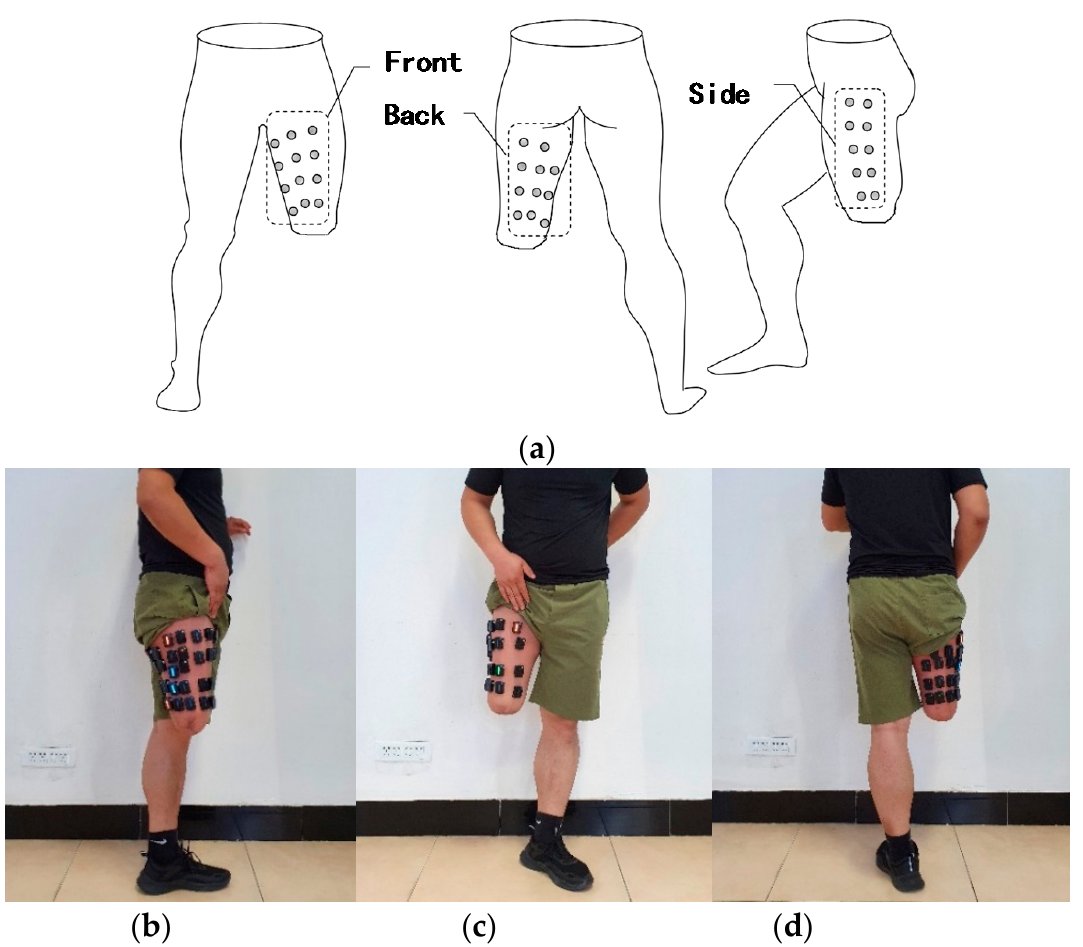
Figure 2. EMG electrodes distribution of the residual limb, ( a ) schematic diagram of electrode distribution, ( b ) side view, ( c ) front view, ( d ) back view.